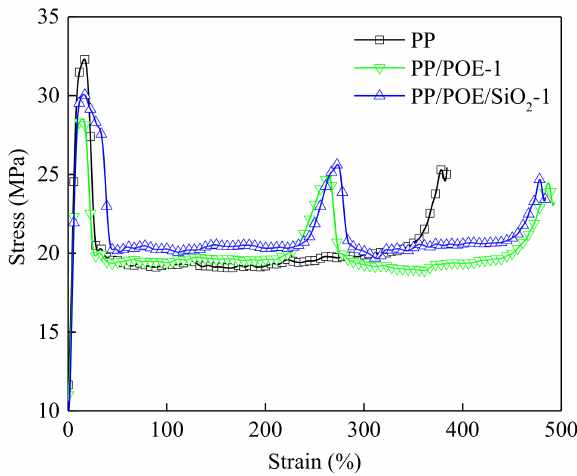
Figure 8. Tensile stress-strain curves of PP and composites.